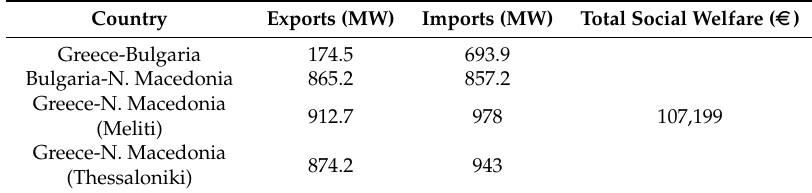
Table 2. Cross-border flows via the FB method for the 3 country scenario.